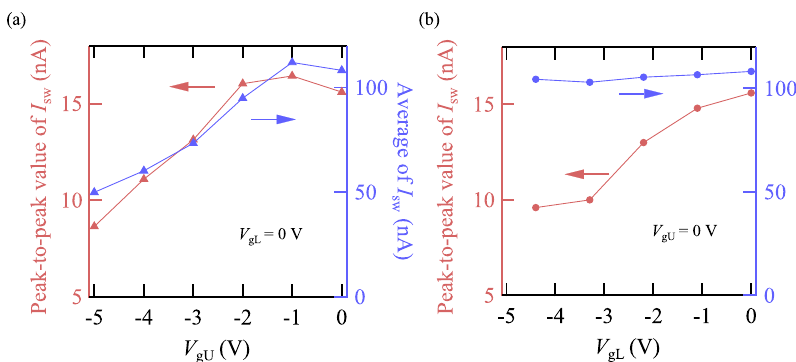
Fig. 4 Local and nonlocal gate control of the switching current oscillation in JJU. a , b Show the peak-to-peak value in red and the average in blue of the switching current in JJU as a function of V gU and V gL , respectively. In the local gate control case in a , both the amplitude and average change with V gU . However, only the peak-to-peak value largely varies in the non-local gate control case in b . This means that the switching current oscillation is derived from the hybridisation between JJU